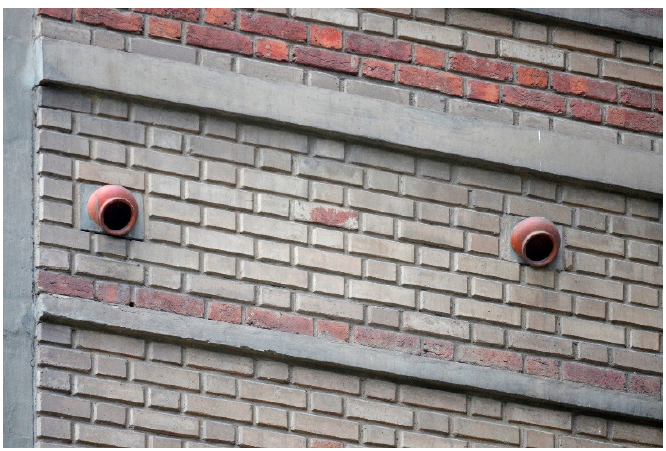
Figure 27. Clay pots inserted randomly into the external walls of DA building offer nesting places for birds and bees (Photo: Author). birds and bees (Photo: